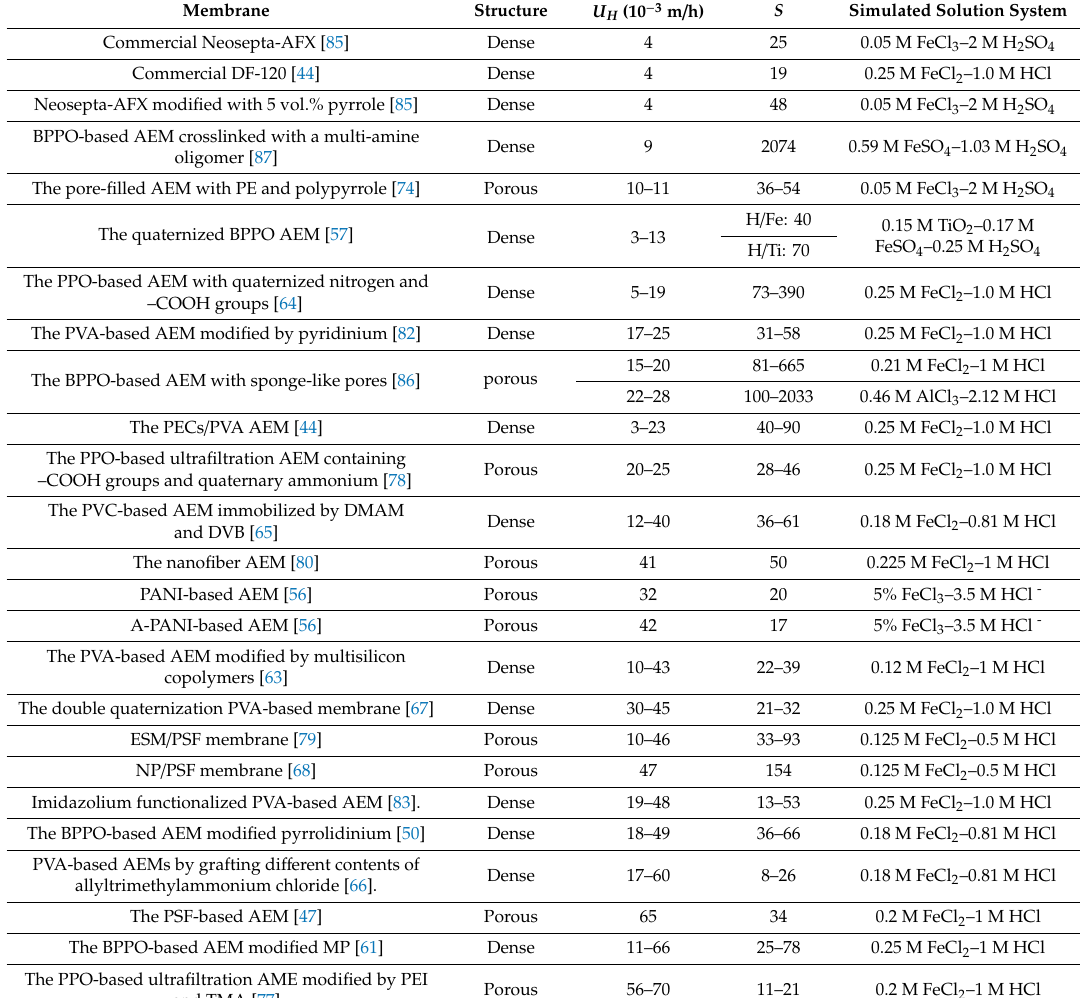
Table 3. The comparison of the comparison of dialysis coe ffi cient ( U H ) and selectivity ( S ) for H + over metal ions of the reported membranes at 25 ◦